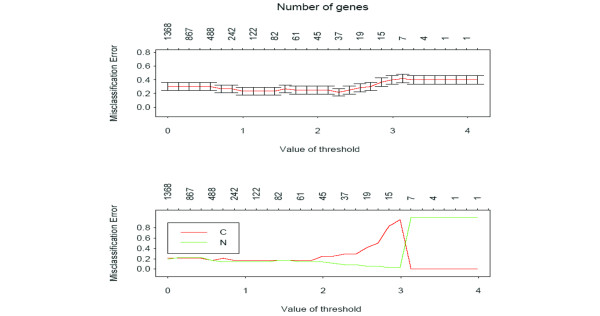
Misclassification rate as a function of threshold value and the number of genes involved. The error was calculated using the majority rule. A nondecision was counted as an error. The upper graph shows that the minimum overall misclassification error was observed at a threshold value of 2.28. The lower graph shows the profile for misclassification error for breast-cancer (C) and non-breast-cancer (N) samples as a function of threshold value and the number of genes involved.